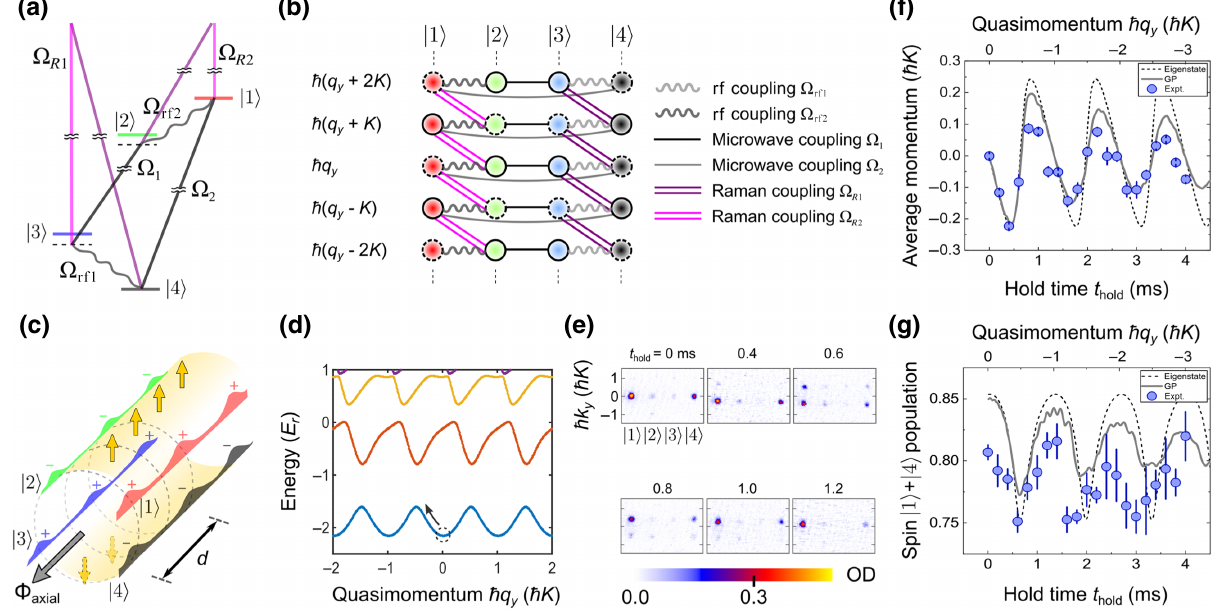
FIG. 3. Topological transition induced by breaking the nonsymmorphic symmetry and effects on transport. (a) A rf wave matching the Raman lasers’ frequency difference is applied to couple | 1 (cid:2) and | 2 (cid:2) , and | 3 (cid:2) and | 4 (cid:2) , with respective coupling strengths (cid:2) rf2 and (cid:2) rf1 . (b) rf couplings (wiggling lines) merge the two independent branches in Fig. 2(a) into one, breaking the nonsymmorphic symmetry. (c) A cylinder with broken nonsymmorphic symmetry. Both the BEC density and phase modulations have a periodicity of d (see also Fig. 6 in Appendix F). The synthetic axial magnetic field, represented by the thick black arrow, corresponds to a magnetic flux (cid:9) axial (see the text). (d) Band structure showing the band gap opening is calculated using similar parameters to those for Fig. 2(b) with additional rf couplings (cid:2) rf1(rf2) = 1.4 ( − 2.0 ) E r with (cid:9) axial /(cid:9) 0 = 0.6. (e) Select TOF images at various t hold and quasimomentum for transport of a BEC starting around q y = 0 [dashed circle in (d)] in the ground band. Panels (f) and (g) respectively show atoms’ average mechanical momentum and spin population versus t hold and